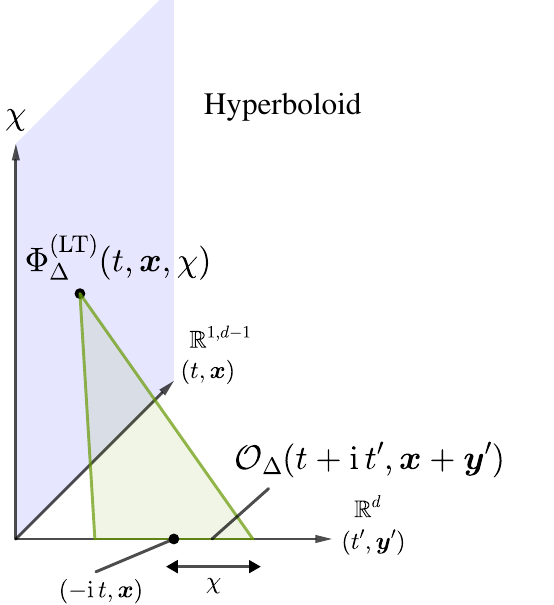
Figure 5 . The HKLL-type representation of the scalar (cid:12)eld propagating on the hyperboloid (5.11). The bulk scalar (cid:12)eld given by (5.12) is constructed by smearing a scalar primary O (cid:1) on the Eu- clidean space with the bulk to boundary propagator analogous to the HKLL